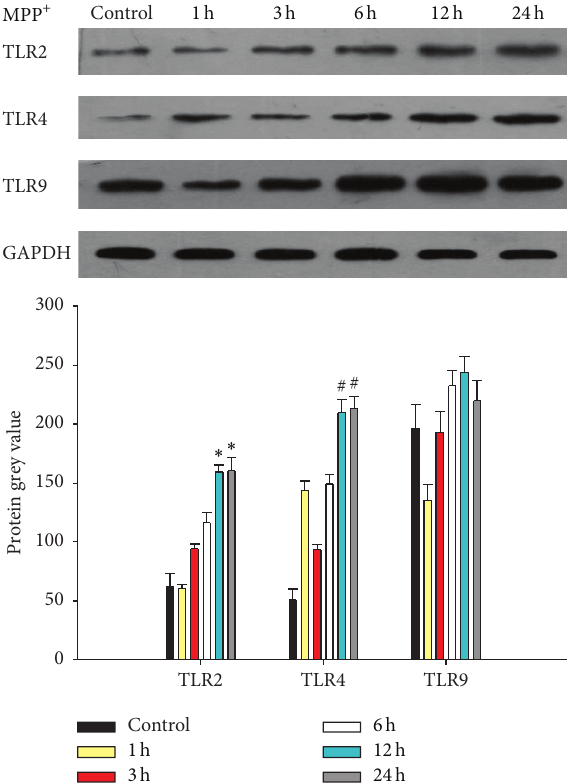
Figure 6: The changes in the protein levels of TLR2, TLR4, and TLR9 in the BV-2 cells exposed to MPP + for different durations. Note that there was a statistical increase in the level of TLR2/TLR4 protein after 0.1mM MPP + incubation for 12 hours and 24 hours ( ∗ 𝑃 < 0.05 versus TLR2 control group; # 𝑃 < 0.05 versus TLR4 control group) and no significant difference in TLR9 protein between 0.1mM MPP + group and